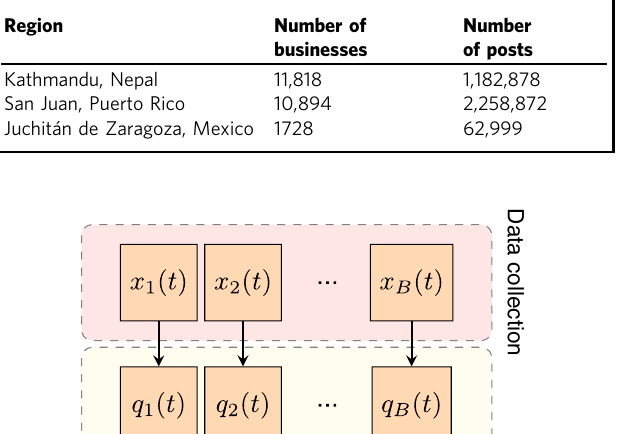
Table 1 Business data collected from Facebook in the three regions considered. The locations of the businesses are shown in Fig. 1a – c.